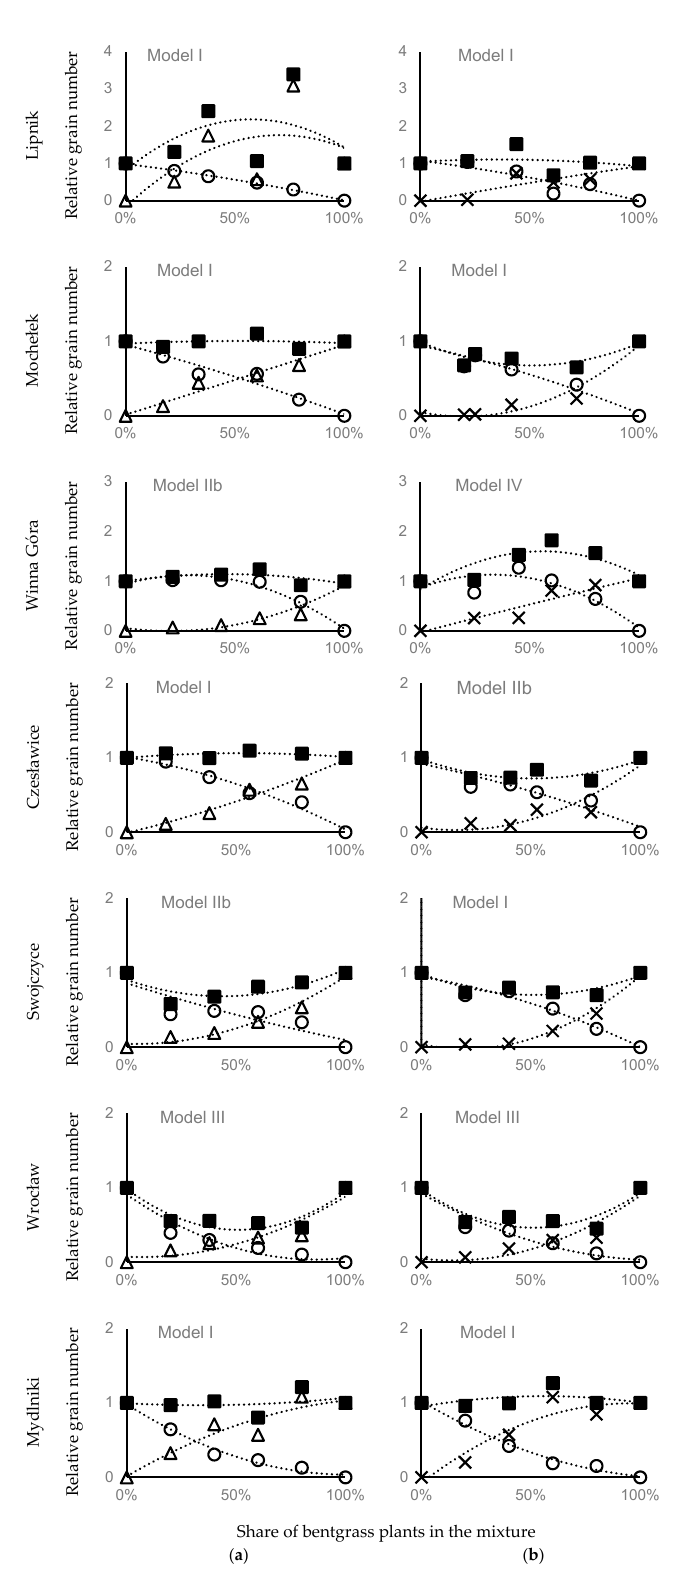
Figure 7. The substitutive competition model for the relative grain number of winter wheat (WW) and bentgrass in the 2018–2019 season, classified according to the t -test and p -values < 0.05. ( a ) Competition between WW and bentgrass with multiple herbicide resistance (RM), and ( b ) competition between WW and herbicide susceptible bentgrass (S). Legend: ○ —WW; Δ —RS; × —S; □ —RS + WW ( a ) or S + WW ( b ).